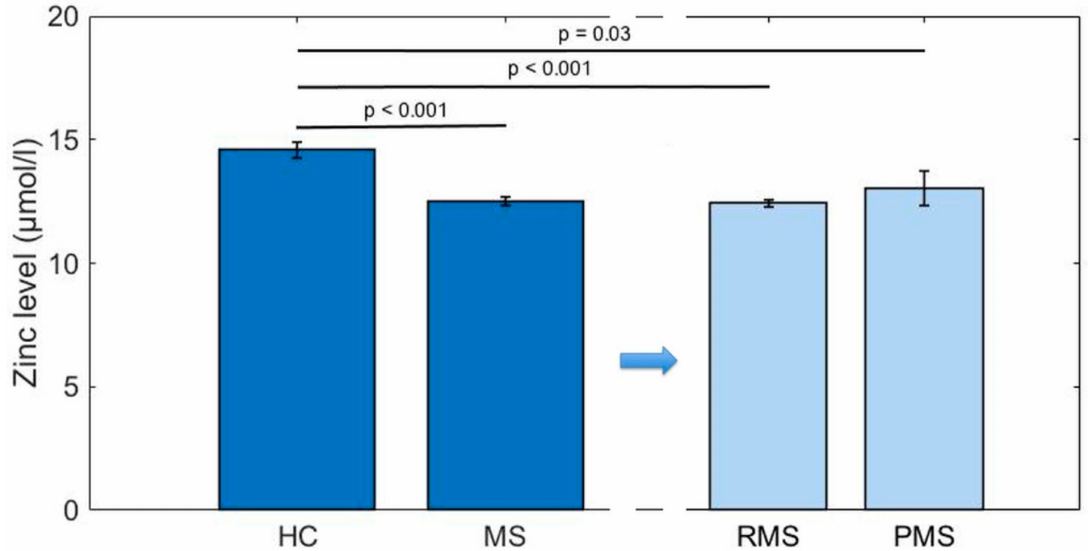
Figure 2. Mean serum zinc levels with standard error of the mean. HC = healthy controls, MS = multiple sclerosis, PMS = progressive multiple sclerosis, RMS = relapsing multiple sclerosis. Group comparisons were conducted using ANOVA with post-hoc Dunn-Bonferroni-testing. Significance threshold: p < 0.05. PMS and RMS patients showed lower zinc blood levels than HCs, while zinc levels between PMS and RMS patients did not